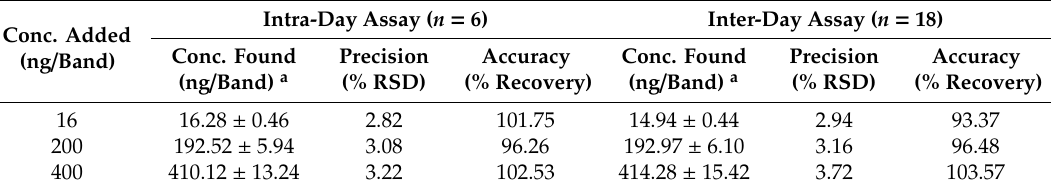
Table 2. Data for intra-day and inter-day precision and accuracy .